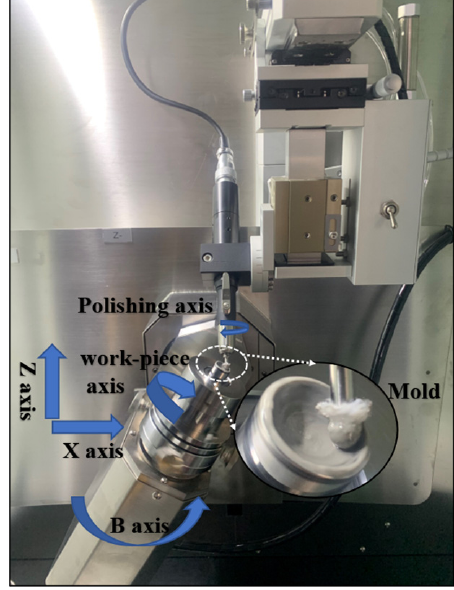
Figure 6. Self-developed polishing equipment. In the formula, R is the radius of curvature of an aspherical vertex, k refers to the aspherical coefficient, and A j stands for the aspherical high-order term coefficient.